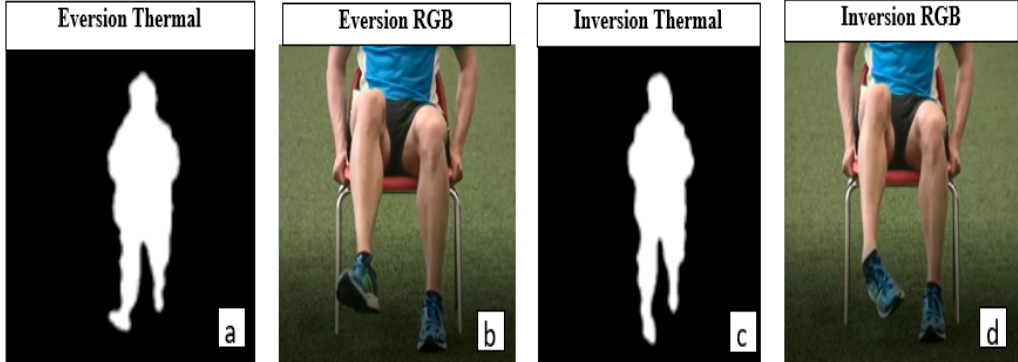
Figure 5. Instances of eversion and inversion of the ankle as presented by RGB and ITA-32 thermal sensors. ( a ) An instance of eversion by an ITA-32 thermal sensor, ( b ) an instance of eversion by an RGB camera, ( c ) an instance of inversion by an ITA-32 thermal sensor, and ( d ) an instance of inversion by an RGB camera.